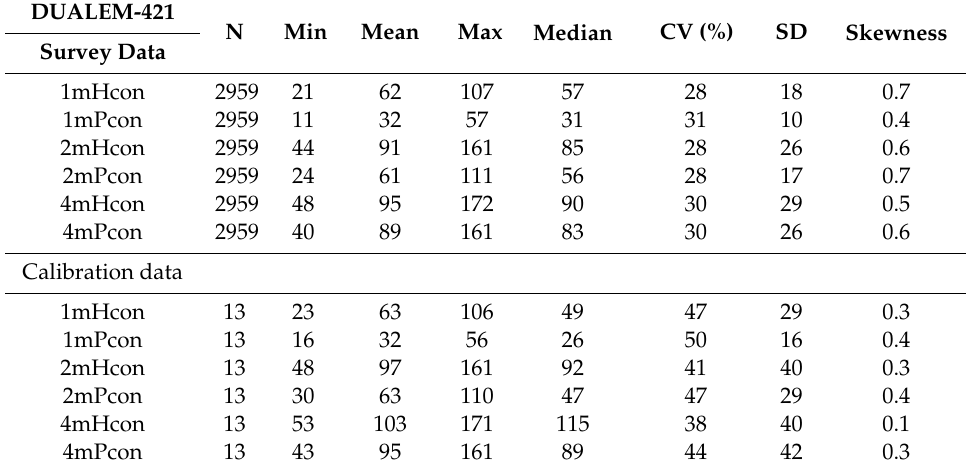
Table 1. Summary statistics of apparent electrical conductivity (EC a —mS m − 1 ) measured by a DUALEM-421 for the entire survey transect and at the 13 calibration sites. Hcon—horizontal coplanar array and Pcon—perpendicular coplanar